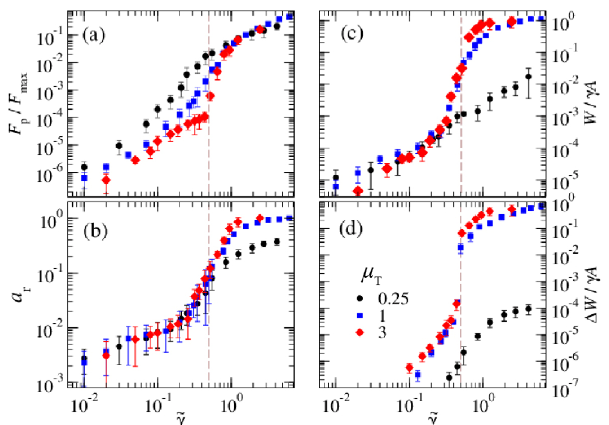
64.  r Here only one f